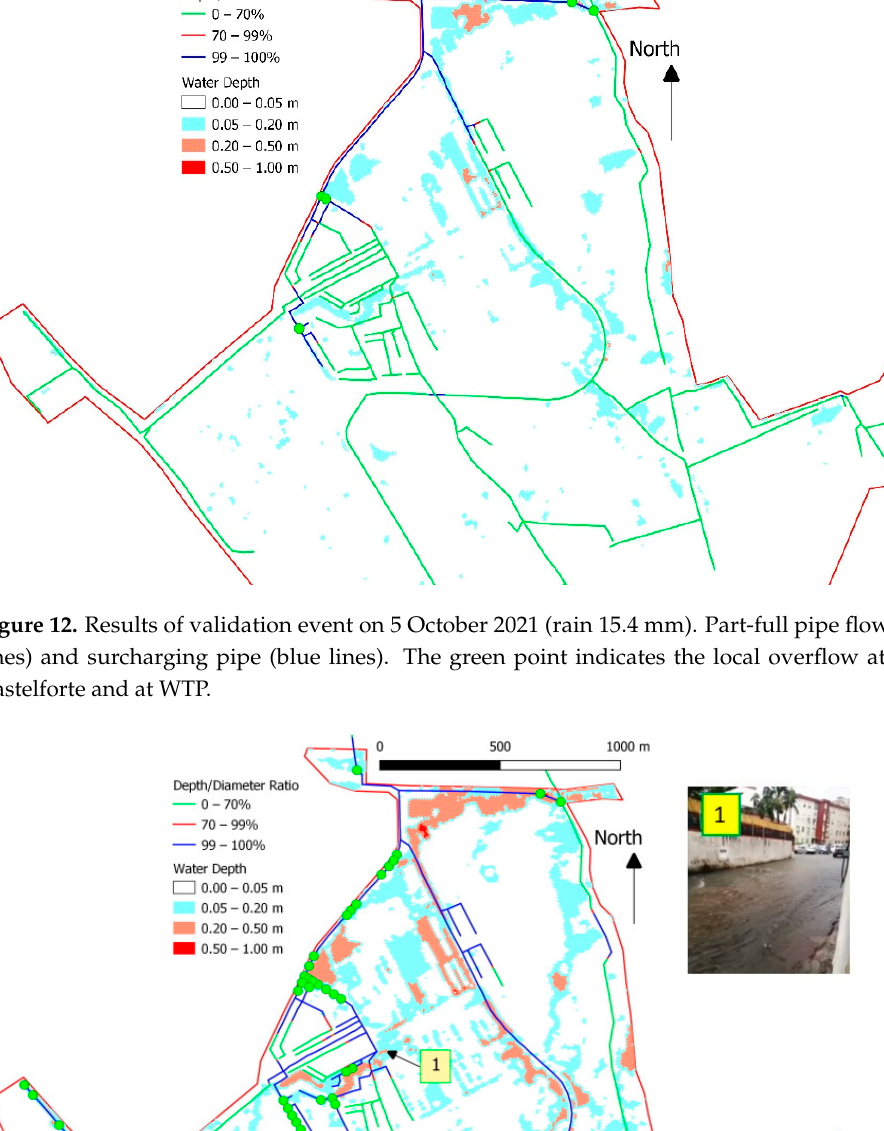
Figure 12. Results of validation event on 5 October 2021 (rain 15.4 mm). Part-full pipe flow (green lines) and surcharging pipe (blue lines). The green point indicates the local overflow at Piazza Castelforte and at WTP.